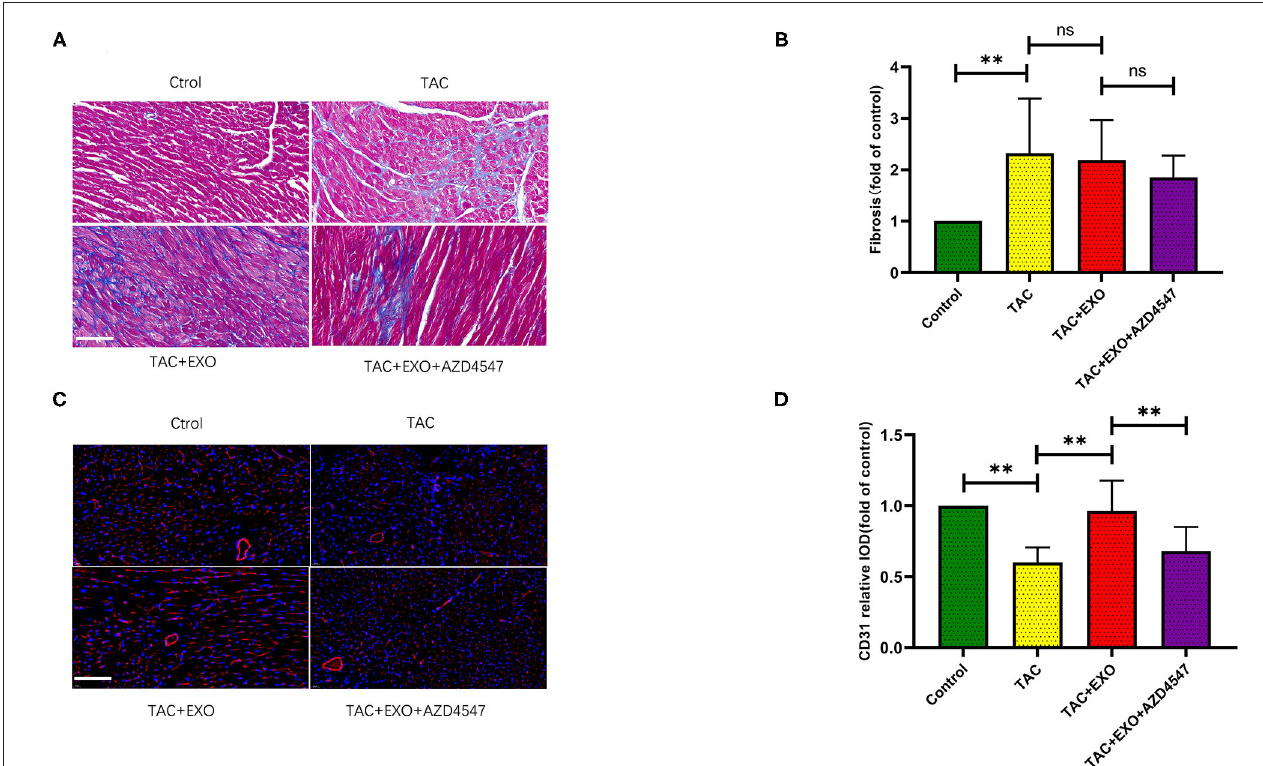
FIGURE 4 | ESCs-derived exosomes increased cardiac angiogenesis and have no effect on the interstitial fibrosis. (A,B) TAC induced marked myocardial fibrosis, as evidenced by Masson staining. However, exosomes administration had no significant effect on the TAC induced myocardial fibrosis (scale bar, 100 um). (C,D) CD31 expression was markedly decreased in the TAC group which could be obviously rescued by exosomes administration ( n = 5–8). * p < 0.05,** p < 0.01.